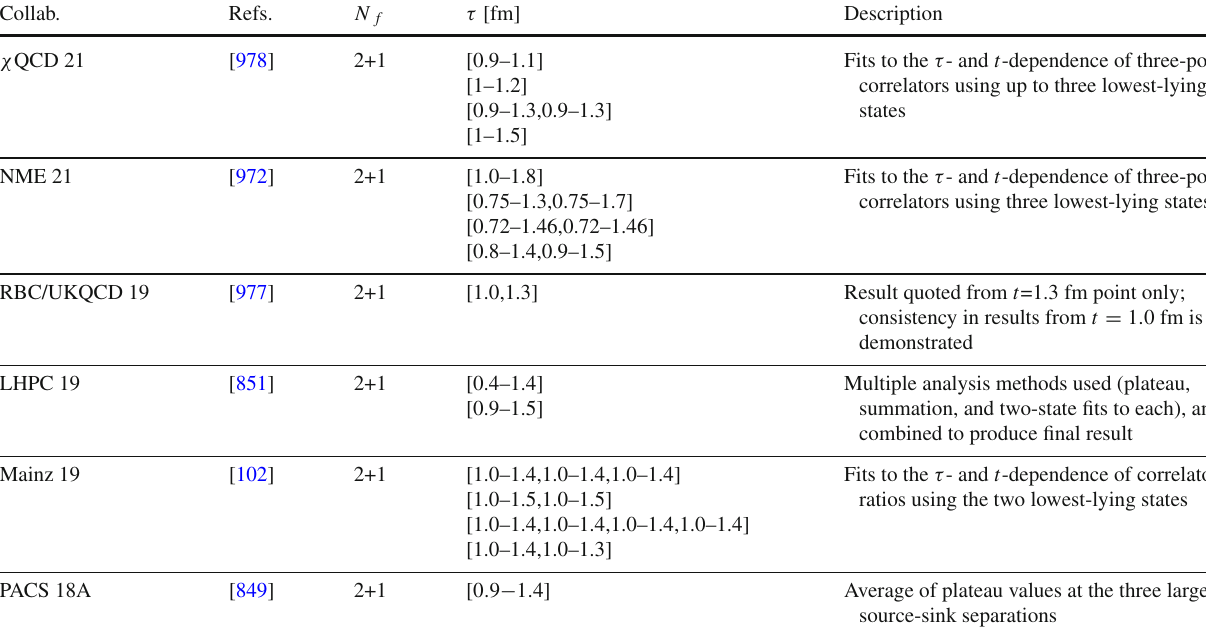
Table 183 Control of excited state contamination in determinations of the isovector axial, scalar and tensor charges with N f = 2 + 1 quark flavours. The comma-separated list of numbers in square brackets denote the range of source-sink separations τ (in fermi) at each value of the bare coupling Collab.